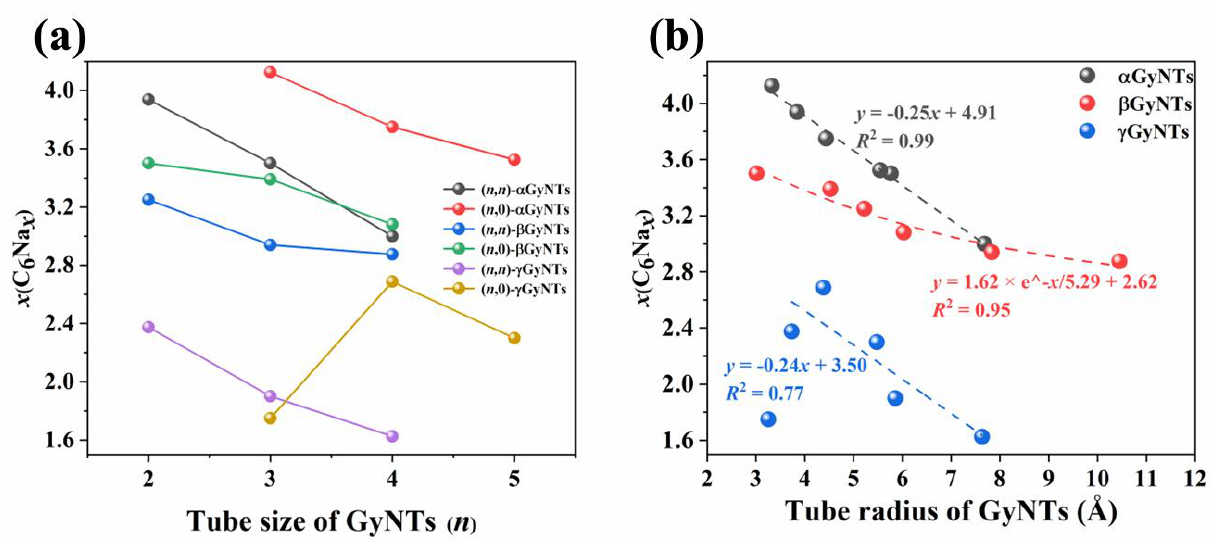
Figure 6. The changes of maximum storage capacity as a function of ( a ) tube size and ( b ) tube radius.